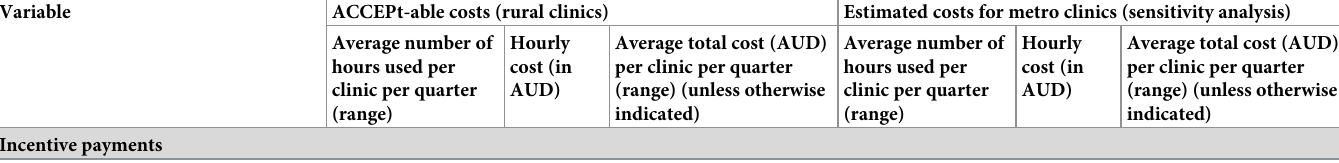
Table 3. Cost and consequences